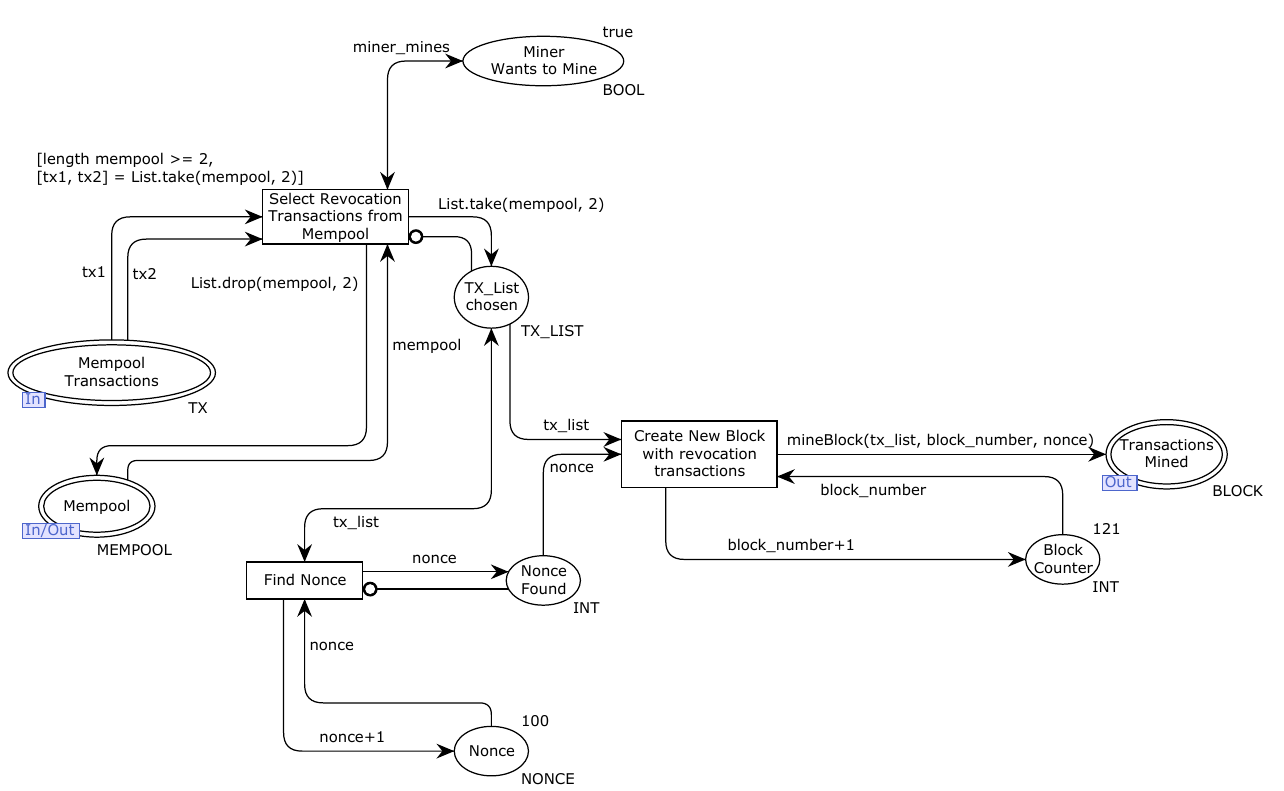
Figure 15. ‘Mine Revocation Transactions’ sub-module of the BlockVoke CPN model.